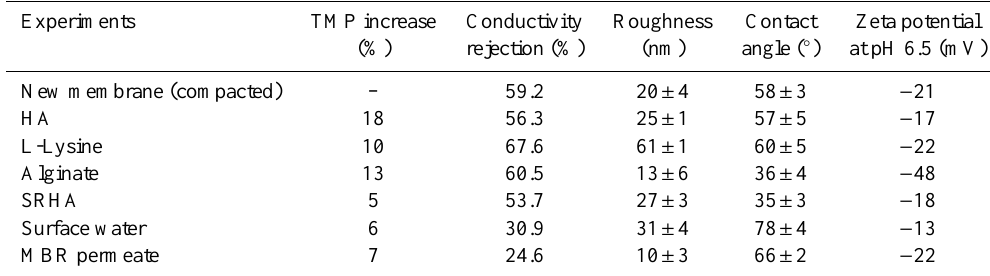
Table 5. Characteristics for compacted and fouled NF270 in terms of TMP increase, salt rejection, roughness, contact angle and zeta